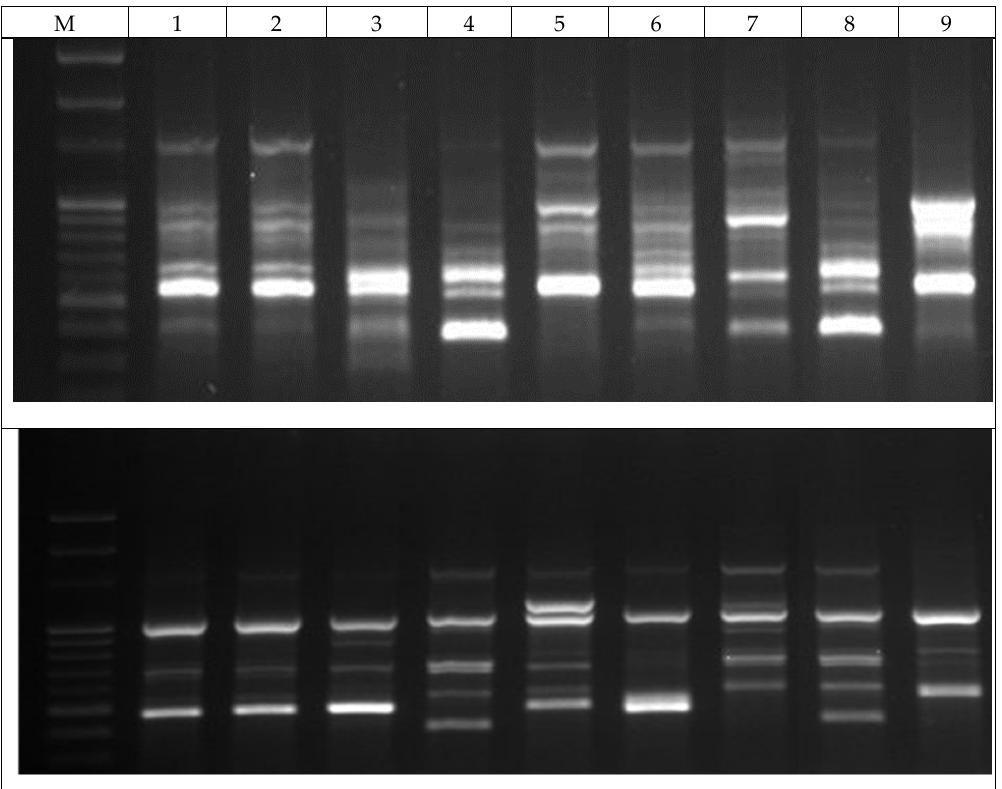
Figure 4. The example of a pattern among the three Korean native Thymus quinquecostatus cultivars and the six commercial Thymus vulgaris cultivars using OPB-01 (top) and OPA-11 (bottom) primers separated in 1.2% agarose gel electrophoresis. M, PCR marker; 1–6, commercial Thymus vulgaris cultivars: (1, lemon; 2, golden; 3, carpet; 4, orange; 5, silver; and 6, creeping); 7–9, Korean native Thymus quinquecostatus cultivars (7, Odae Mt; 8, Wolchul; 9, Jiri). Table 5. Bands and polymorphism revealed by the RAPD primers among the 9 Thymus cultivars. Primer Total No. of Bands No. of Polymorphic Bands Polymorphism (%)